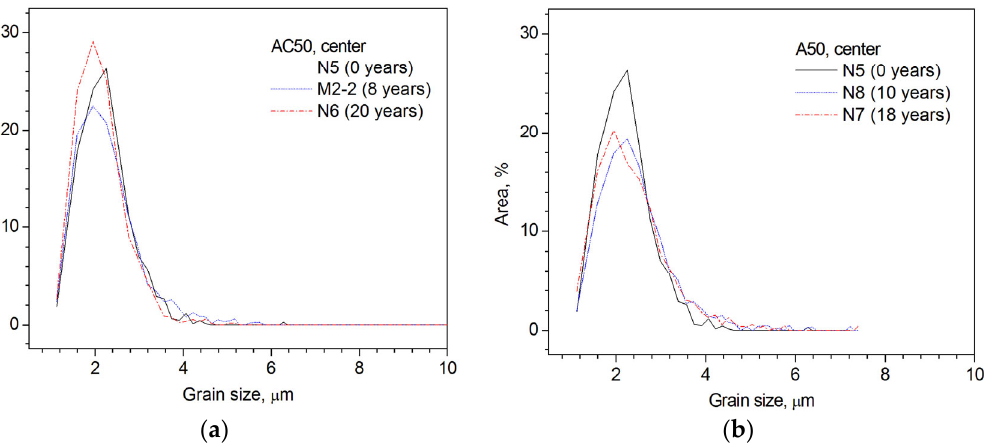
Figure 4. Dependencies of the relative area occupied by grains vs. their size for the cross-sections of outer wires from the ( a ) AC50 and ( b ) A50 cables at the centers of the samples. All dependencies are given on the same scale for comparison. Numbers of samples and their service lives are indicated in the legends of the Figures.